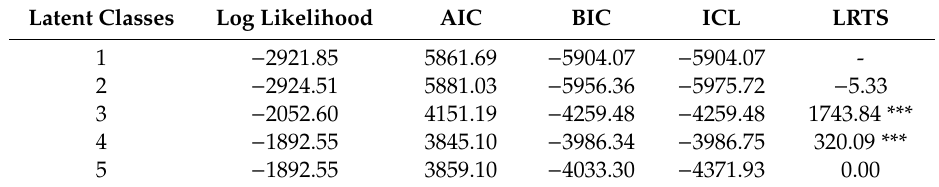
Table 4. Comparison of number of latent classes according to Latent Profile Analysis